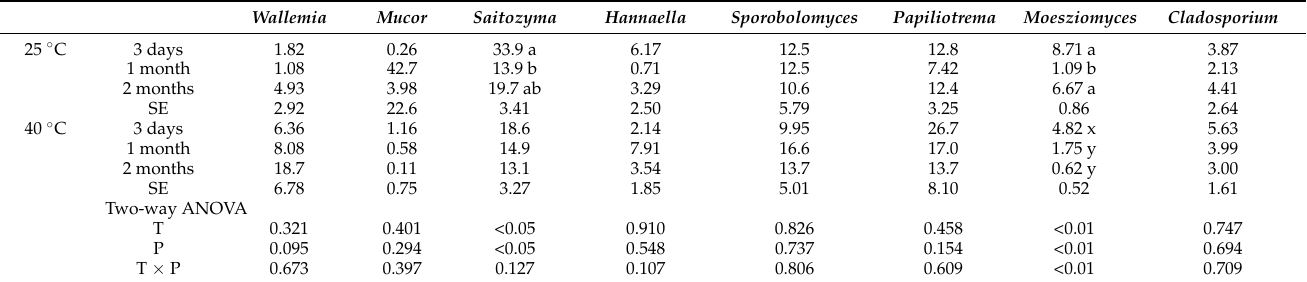
Table 6. Relative abundances (%) of the eight most abundant fungal genera in wilted guinea grass silage stored at 25 and 40 ◦ C for 3 days, 1 month, and 2 months.